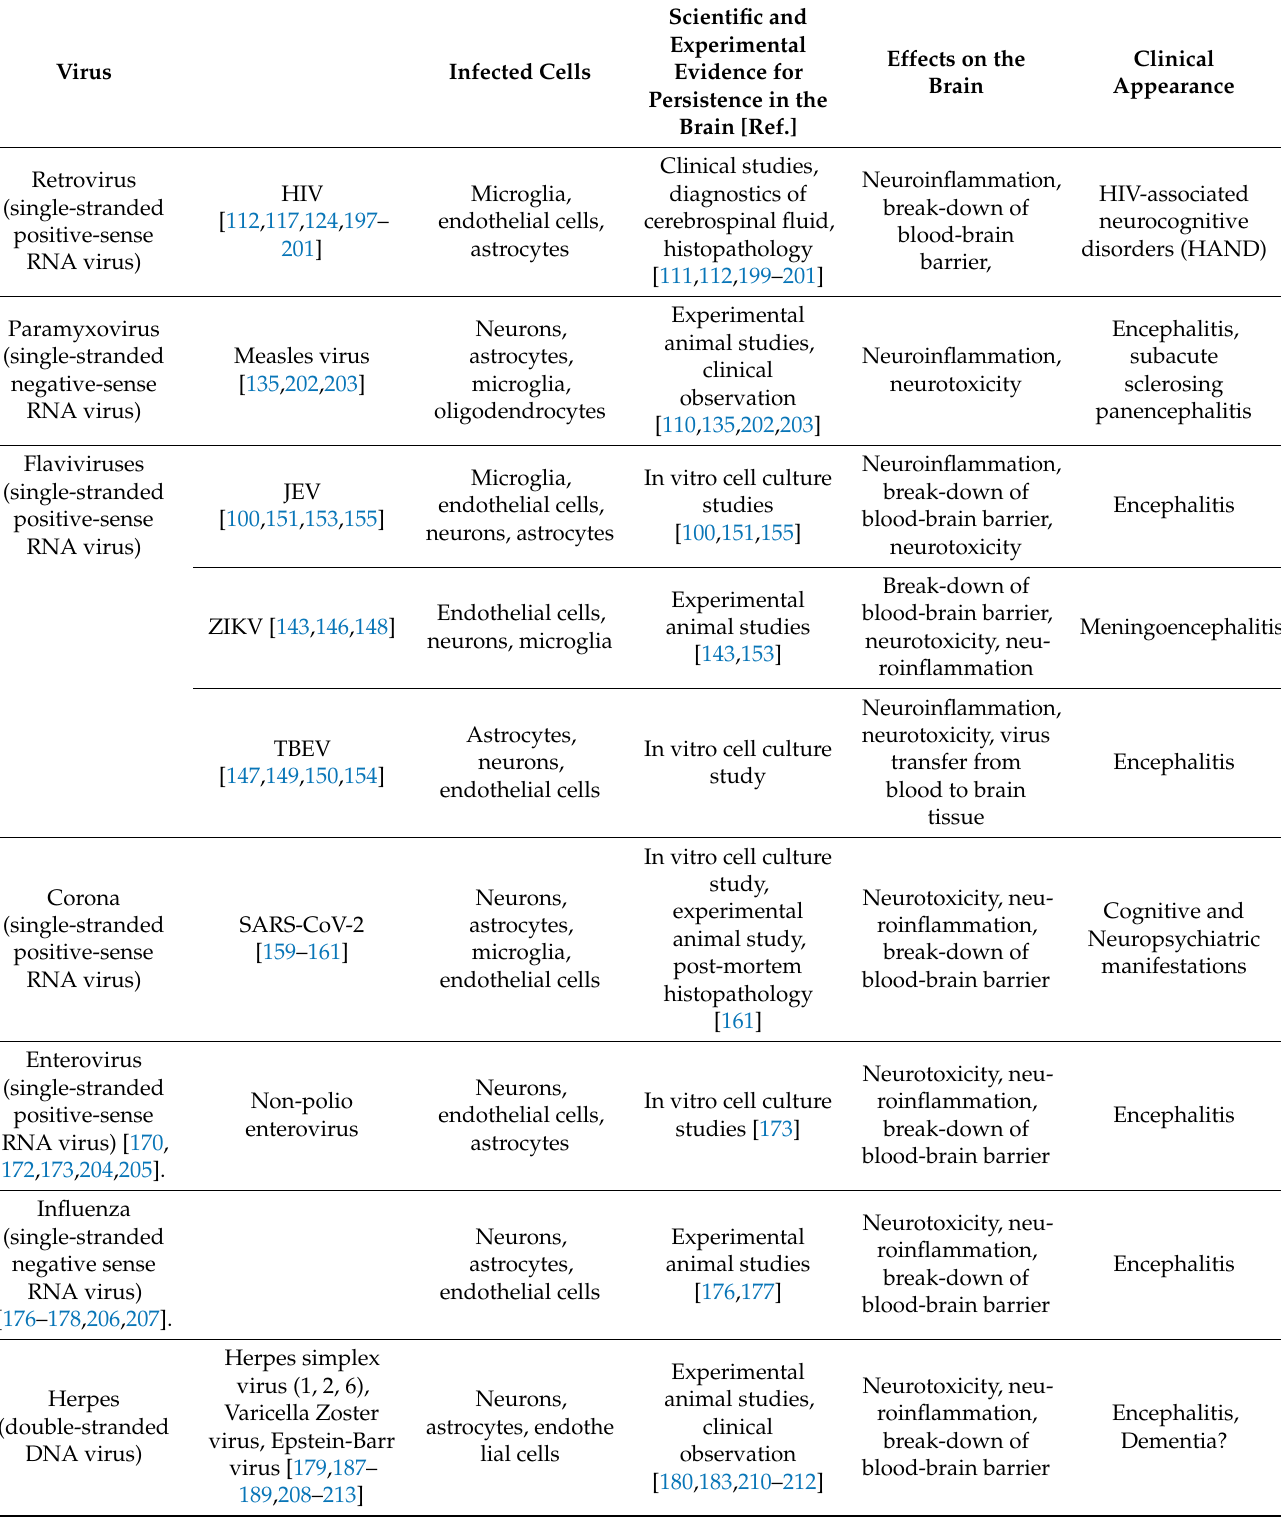
Table 1. Neurotropic viruses, target cells, scientific and experimental evidence for persistence in the brain, effects on the brain and clinical appearance 1